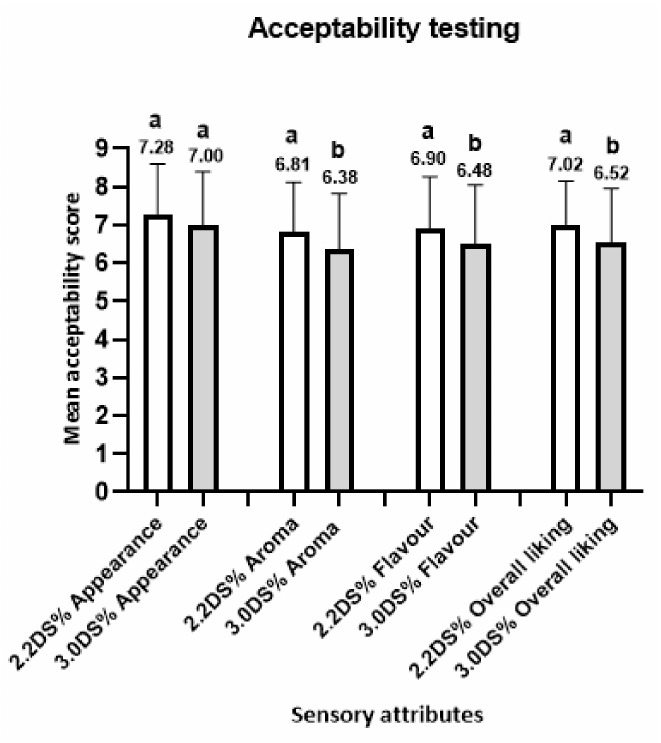
Figure 4. Evaluation mean scores for sensory attributes of the ketchups with 2.2% oven-dried S. ramosissima (2.2DS%) and 3.0% oven-dried S. ramosissima (3.0DS%) ( n = 102 consumers). Each sensory attribute was evaluated using a nine-point hedonic scale where 1 = “disliked extremely” and 9 = “liked extremely”. The letters (a and b) correspond to the statistical analysis performed to calculate the existence of a significant difference ( p < 0.05) between each sample according to the unpaired t